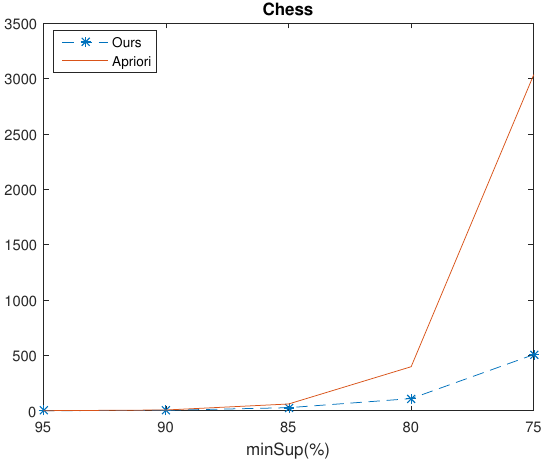
Figure 4. Execution time of the two algorithms in Chess dataset for various minSup